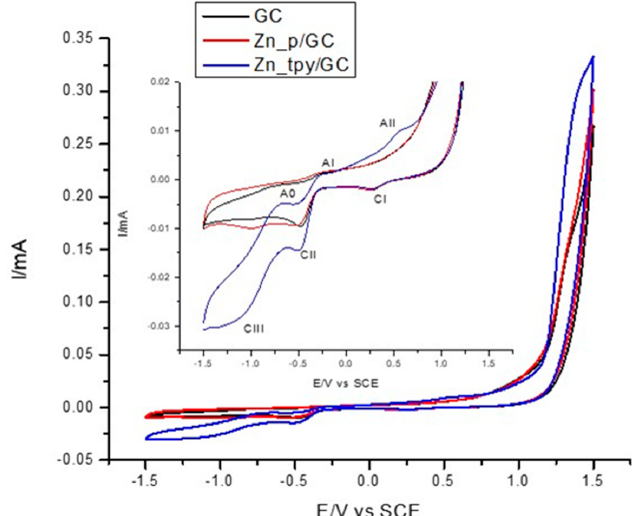
Figure 5. Cyclic voltammograms recorded in 0.1 M NaOH supporting electrolyte at a scan rate of 0.05 V · s − 1 with GC electrode (black line), Zn_p/GC (red line) and Zn_tpy/GC electrode (blue line) within the potential range of − 1.5 to +1.5 V/SCE; Inset: details of CVs, including the anodic and cathodic peaks marking .